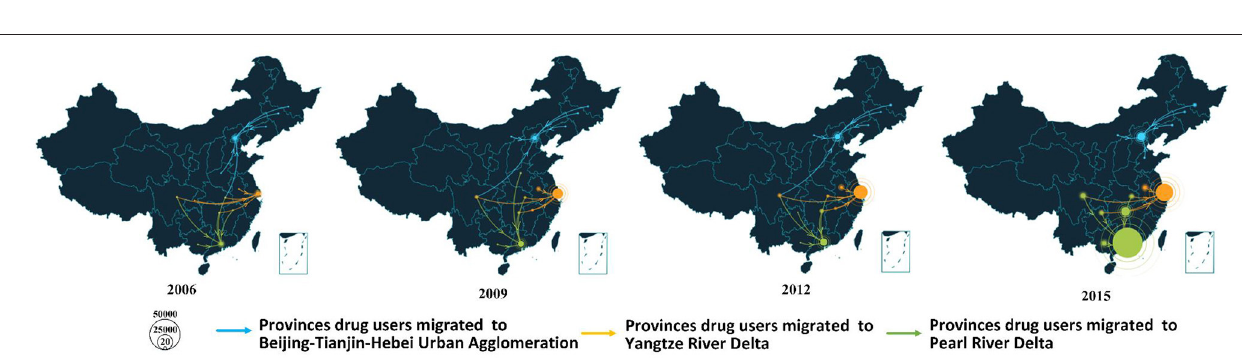
of methamphetamine in the mainland of China (14,